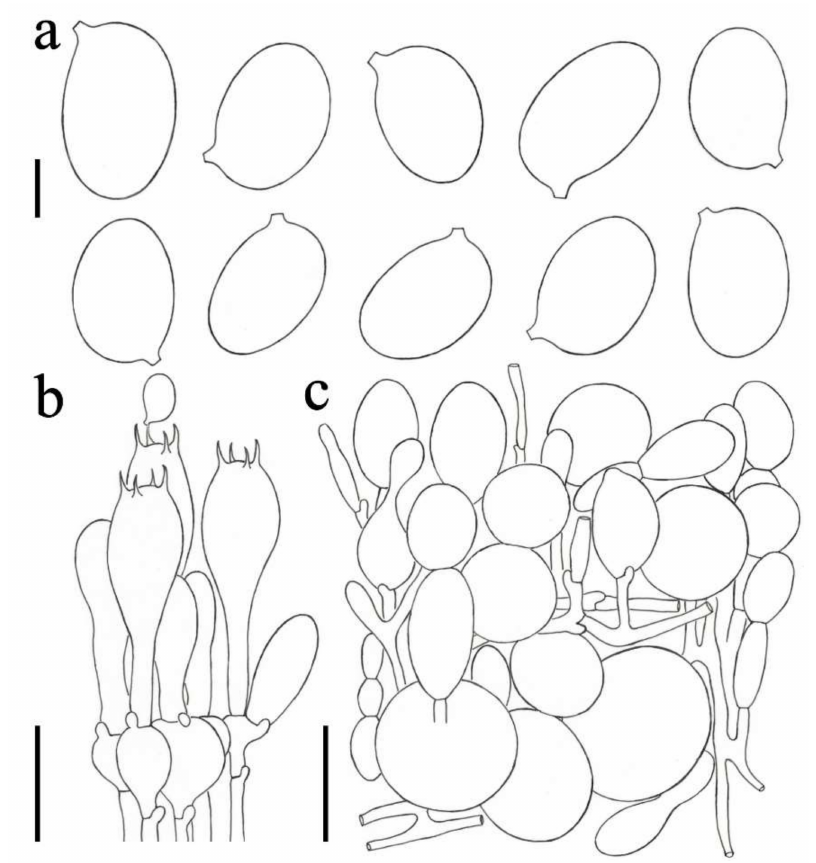
Figure 3. Amanita kalasinensis (CMUB-39966, holotype). ( a ) Basidiospores. ( b ) Hymenium and subhymenium. ( c ) Longitudinal section of volval remnants on pileus. Bars: ( a ) 4 µ m; ( b ) 20 µ m; ( c ) 40 µ